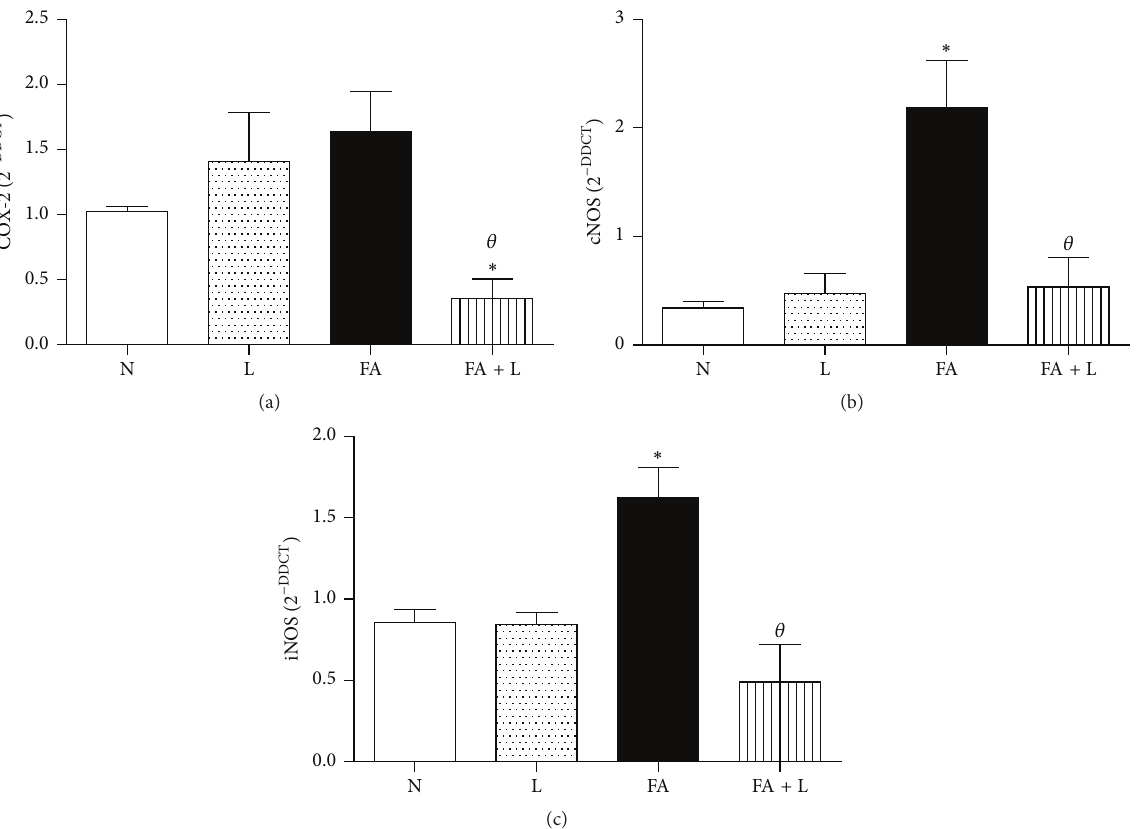
Figure 3: Photobiomodulation therapy decreases oxidant enzymes after FA exposure in the lung. Group of rats was exposed to FA inhalation (1%, 90min/day, 3 days) and treated or not with LLLT (30 mW, 1.8 J, 60s/point, total 540 s, 1 and 5 h after each FA inhalation). In parallel, group of rats were treated only with laser and nonmanipulated rats were used to obtain basal parameters. The oxidant enzymes were determined 24 h after the last FA inhalation. Data mean ± SEM of 6 animals per group. ∗ 𝑃 < 0.05 in relation to N and L groups; 𝜃 𝑃 < 0.05 in relation to FA